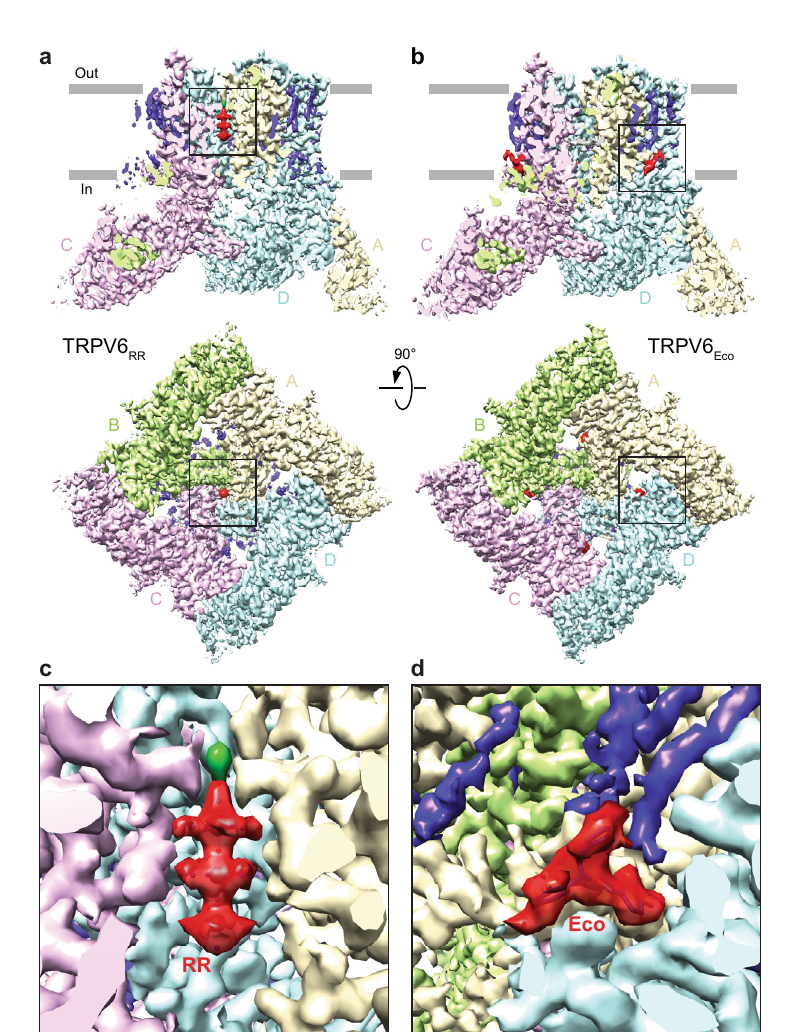
Fig. 2 Structures of TRPV6 in complex with ruthenium red and econazole. a , b Cryo-EM structures of TRPV6 RR ( a ) and TRPV6 Eco ( b ) viewed parallel to the membrane (upper row) or intracellularly (bottom row), with each of the four subunits colored differently, lipids in purple and inhibitors in red. c , d Close-up views of cryo-EM density for RR ( c ) and econazole ( d (Figs. 5b – d, 3e, f). Correspondingly, S6 in TRPV6 RR and TRPV6 Eco was entirely α -helical, typical for the closed con- formation of TRPV6. The open-to-closed state transformation of the lower pore in TRPV6 Open compared with TRPV6 RR and TRPV6 Eco included a ~100° rotation and bending away from the pore axis of the intracellular part of S6, as it was described